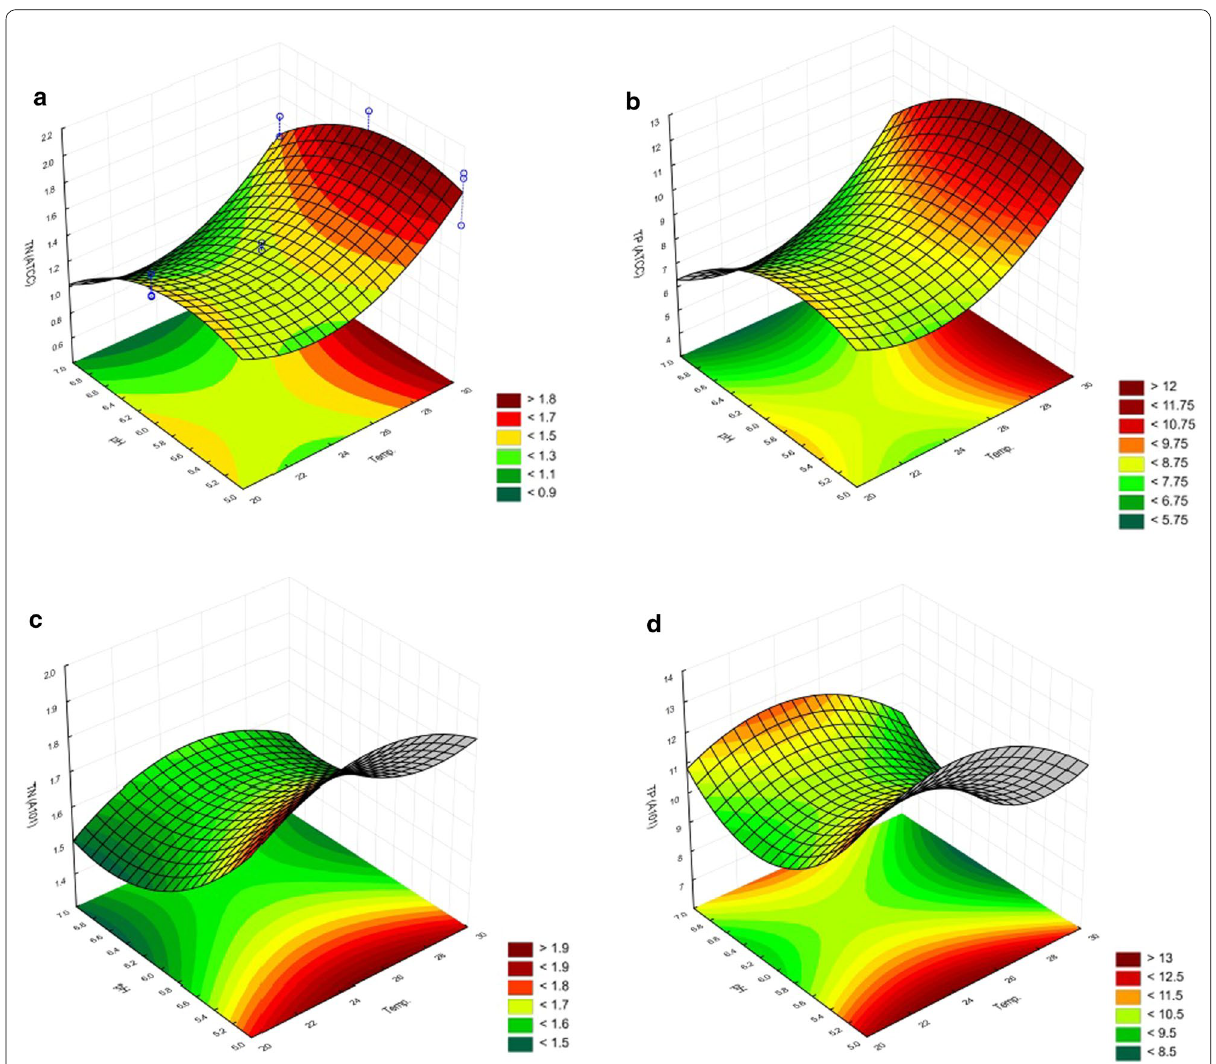
Fig. 4 Surface response model of the influence of pH and temperature on TN and TP values for strains Y. lipolytica ATCC 9793 and Y. lipolytica A-101 cultivated on the YPD medium. a TN( Y. lipolytica ATCC 9793), b TP( Y. lipolytica ATCC 9793), c TN( Y. lipolytica A-101), d TP( Y. lipolytica A-101). TN, total nitrogen; TP, total